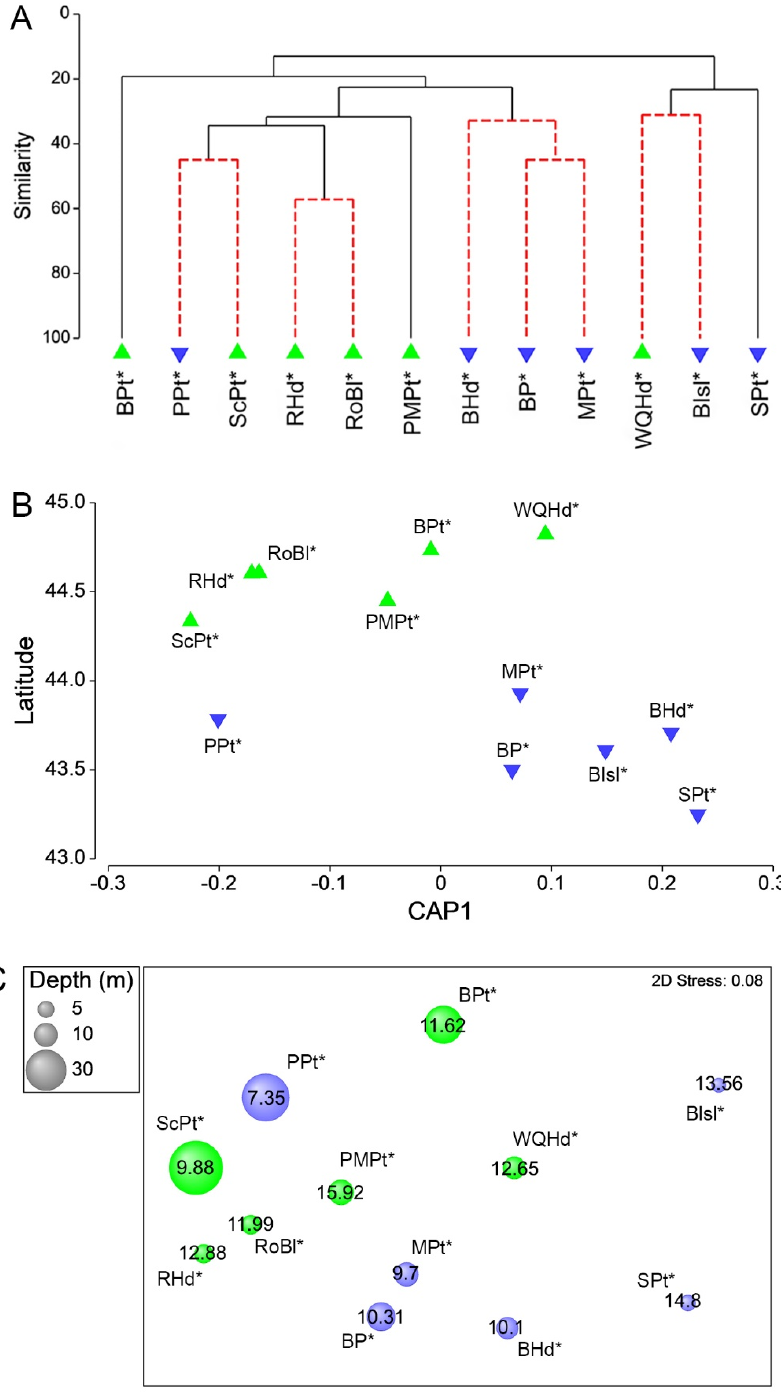
Figure 7. Similarity among subtidal species assemblages at locations proximal to rocky intertidal survey locations. ( A ) Hierarchical cluster analysis. Solid black lines connect assemblages that differ significantly; red dashed lines connect assemblages that are not significantly different (SIMPROF). ( B ) Canonical ordination of species assemblage similarity with latitude. ( C ) nMDS of assemblage similarities displayed with bottom sea water temperatures ( ◦ C) and depth. Symbology: Green bubbles, southern GoM region; blue bubbles, northern GoM region; *, indicates proxy station. Abbreviations: BIsl, Bailey Island; BHd, Bald Head; BP, Biddeford Pool; BPt, Black Point; MPt, Marshall Point; PPt, Pemaquid Point; ScPt, Schoodic Point; SPt, Sea Point; PMPt, Petit Manan Point; RHd, Red Head; RoBl, Roque Bluffs; WQHd, West Quoddy